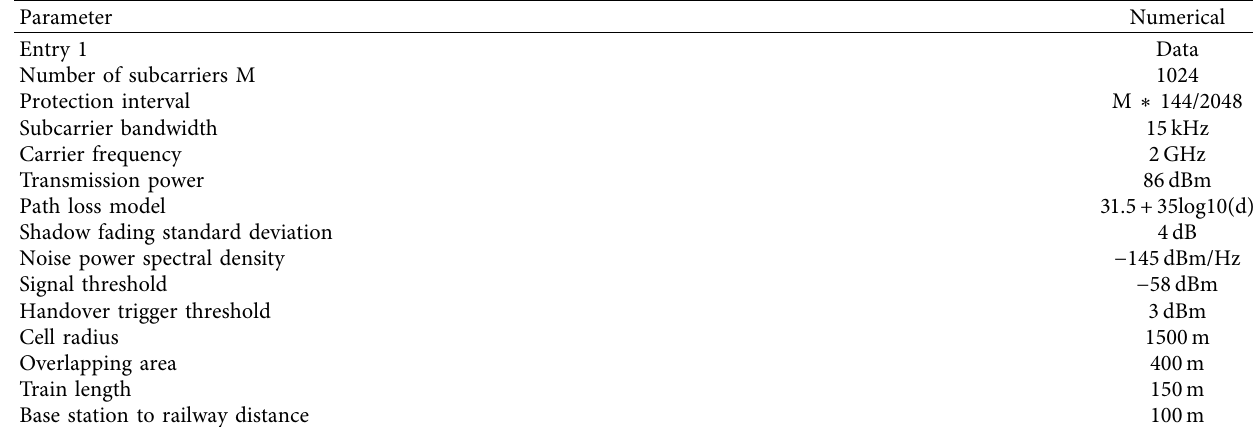
Table 1: Units for magnetic